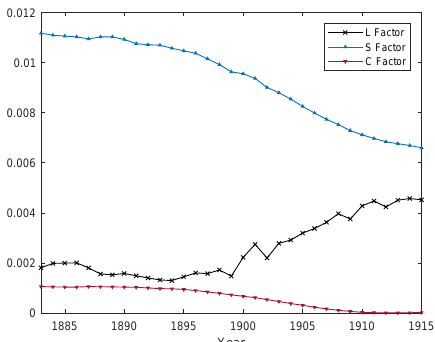
Figure 3. Factors in the Independent AFNS Model.